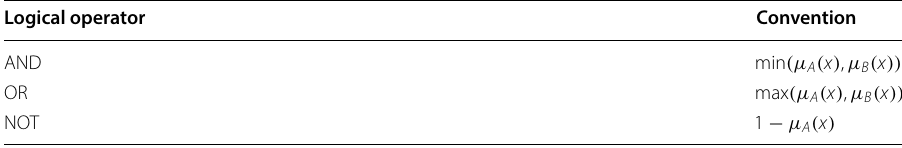
Table 3 Fuzzy logical operator